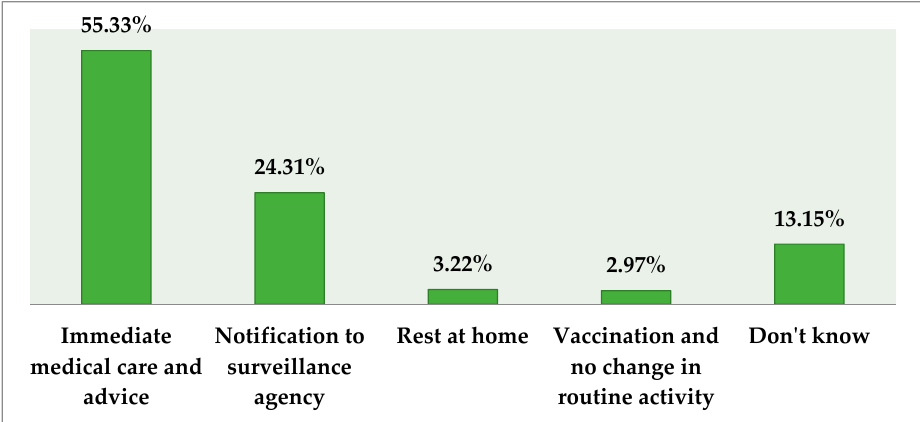
Figure 4. Respondents’ action in case of suspicion of EVD.